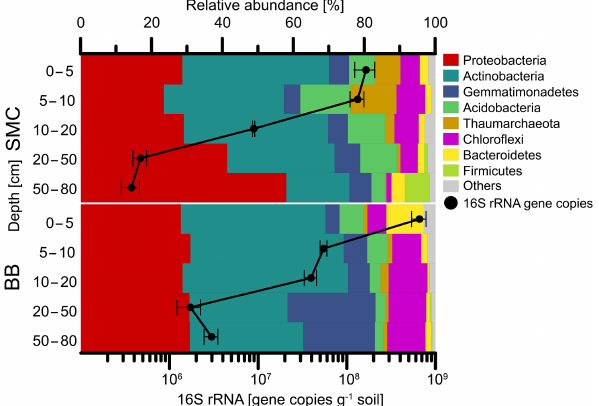
Figure 4. Relative abundances of phyla and bacterial 16S rRNA qPCR gene abundances of soil profiles from Brandy Bay (BB) and Santa Martha Cove (SMC) on James Ross Island, Antarctica. Trip- licates are merged. Only phyla with a relative abundance of at least 5% at a given site are shown. The remaining phyla are summarized as “Others”.